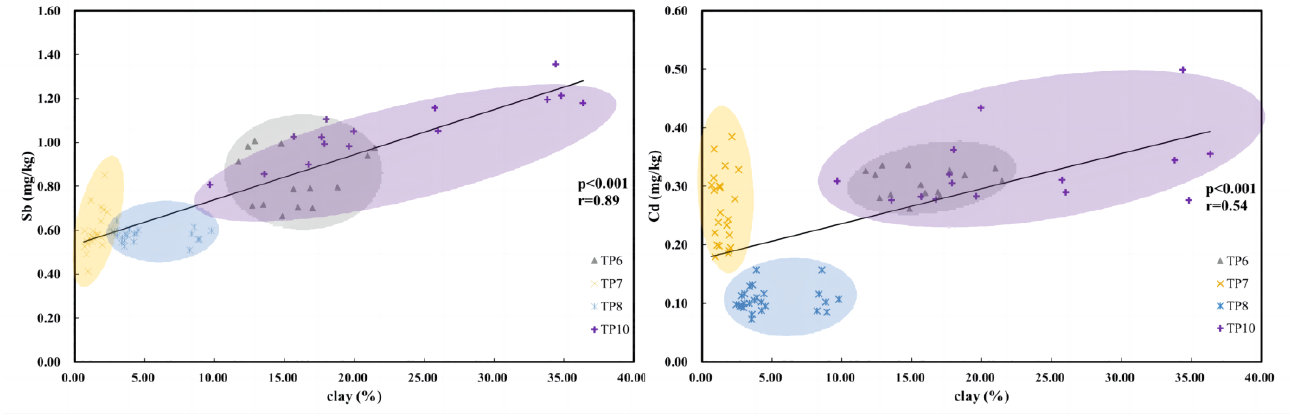
Figure 5. Correlation between PTEs (Sb and Cd) and clay fraction in uncontaminated sediments from TP6, TP7, TP8 and